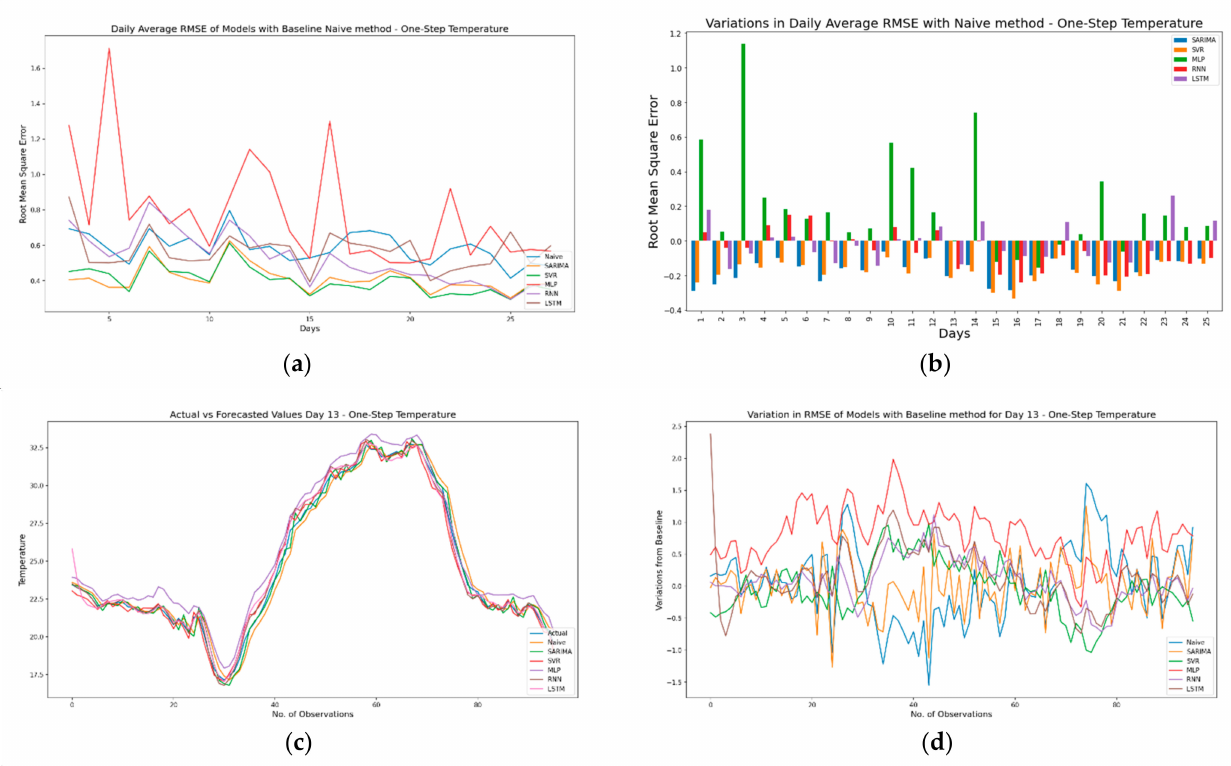
Figure 13. Comparative visualization for model performance against a baseline model—One-step ahead Temperature ( a ) daily average RMSE of different models with a baseline naïve model ( b ) variations in daily average RMSE with performance against naïve model ( c ) combined Actual vs. Forecasts generated by different TSFAs for Day 13 ( d ) variations in RMSE of models against naïve model for Day